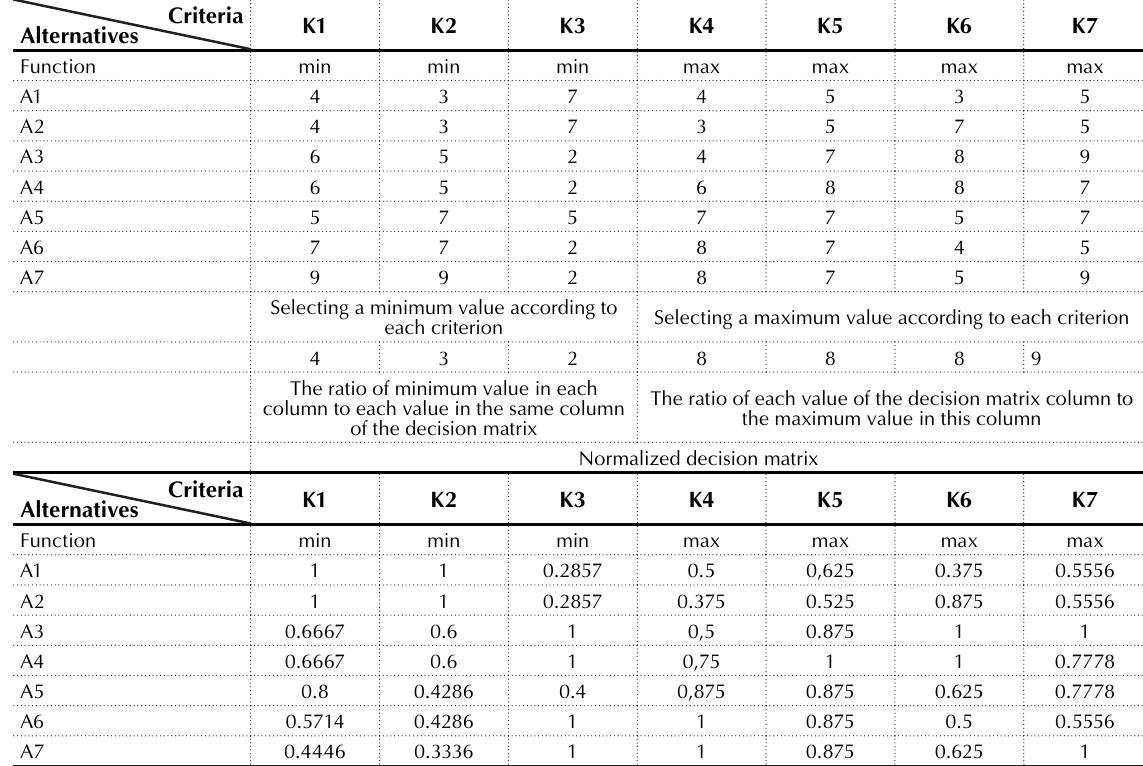
Table 4. Weighted normalized decision matrix